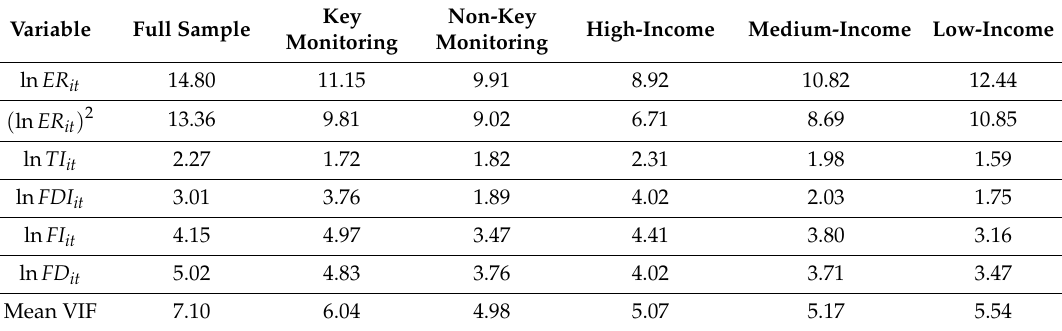
Table 3. Variance inflation factor (VIF) for each regression